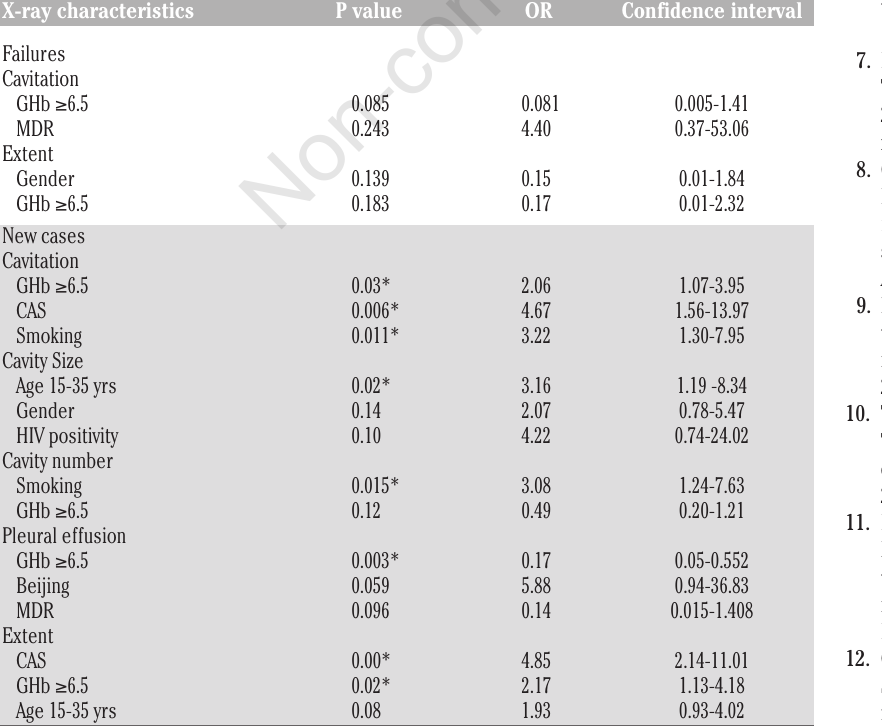
Table 3. Multivariate analysis for various X-ray features. X-ray